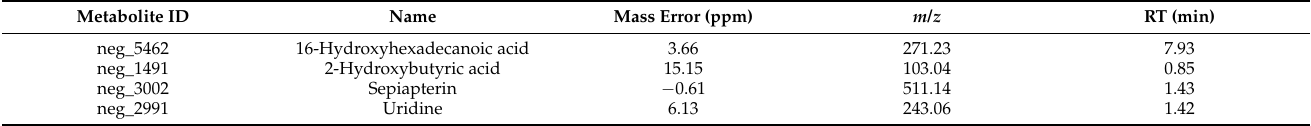
Table 5. Common differential metabolites in HP and C, AS and C, HP and AS.